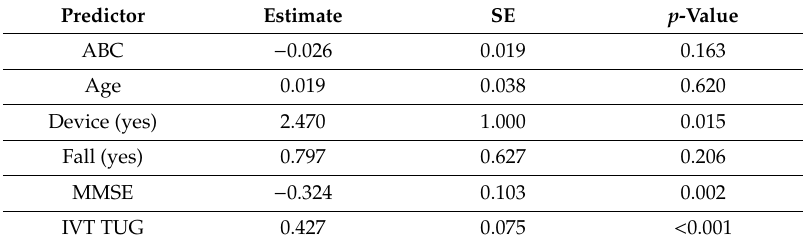
Table 4. Linear regression analysis modeling TUG performance at Follow-up Visit 2.